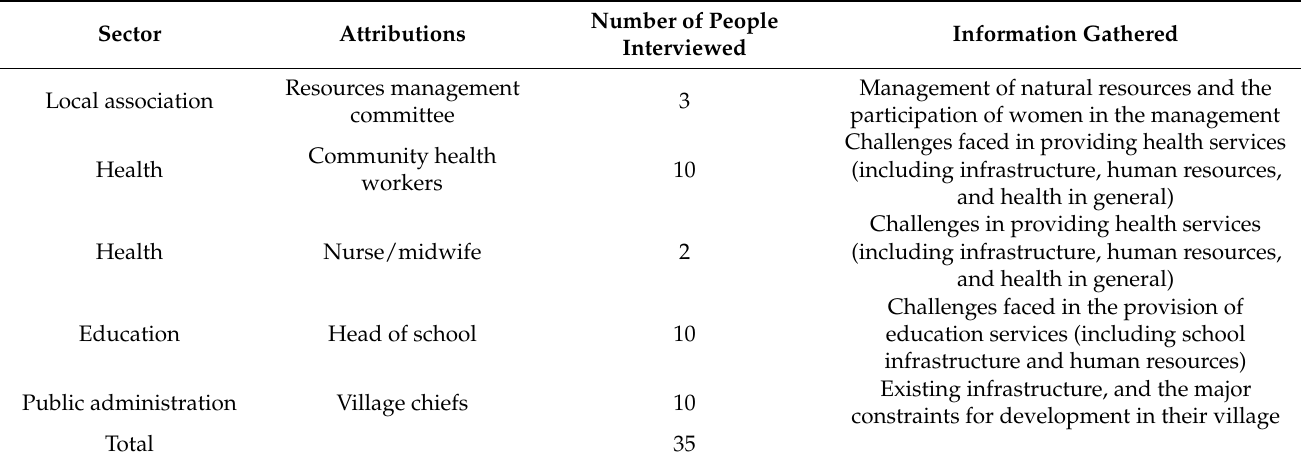
Table 1. Key informants interviewed in the studied villages of the Baie des Assassins.